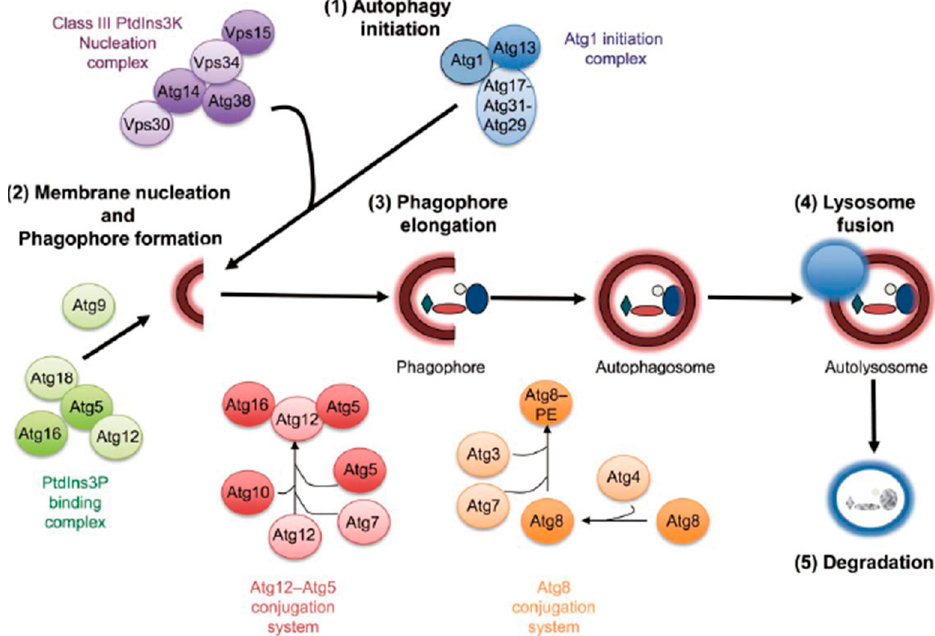
Figure 1. The autophagic process. Autophagy proceeds through at least five discrete steps: initiation, membrane nucleation and phagophore formation, phagophore elongation, lysosome fusion, and degradation. These steps are controlled by at least five different functional groups of proteins: ATG1/Ulk1 initiation complex, class III PtdIns 3-kinase nucleation complex, PtdIns3P-binding complex, conjugation system, and degradation [7] (Arrow shape indicates next step).